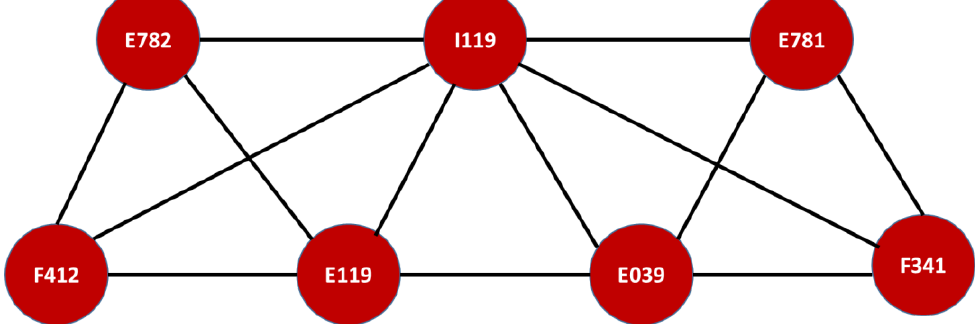
Figure 8. Motifs of diagnoses with the highest coherence level. Morbidity Network of Diagnoses for the victims of the armed conflict in Colombia, residing in the Risaralda province, from 2011 to 2016. Source: authors’ own calculations. Note that the ICD-X codes correspond to: E782: mixed hyperlipidaemia, I119: hypertensive heart disease without heart failure, E119: type 2 diabetes mellitus without complications, E039: hypothyroidism, unspecified, E781: pure hyperglyceridemia, F341: dysthymic disorder, and F412: mixed anxiety and depressive